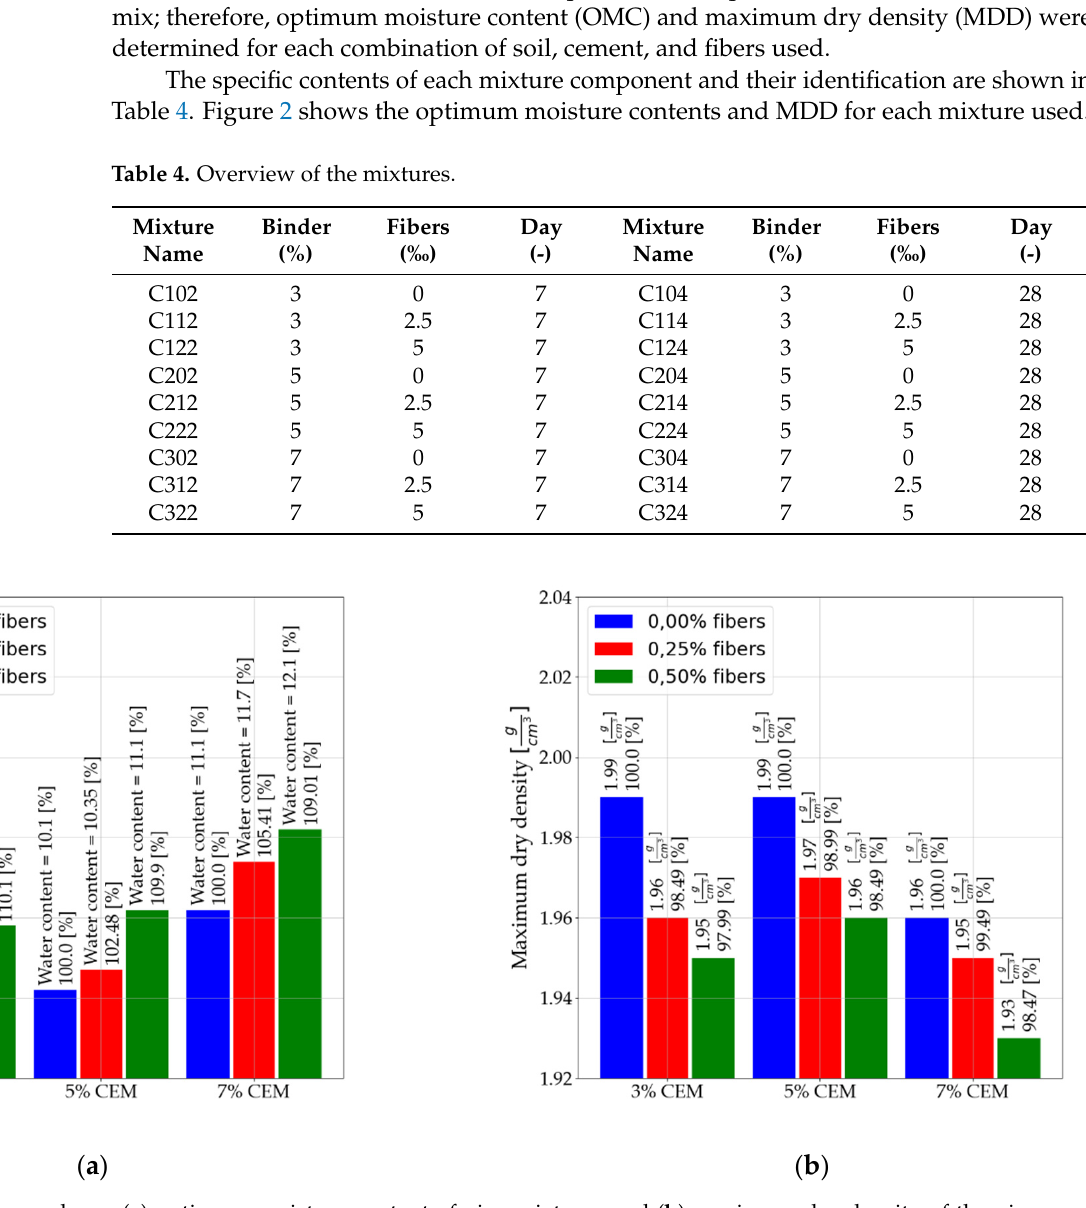
Figure 2. The figure shows ( a ) optimum moisture content of nine mixtures and ( b ) maximum dry density of the nine mixtures.